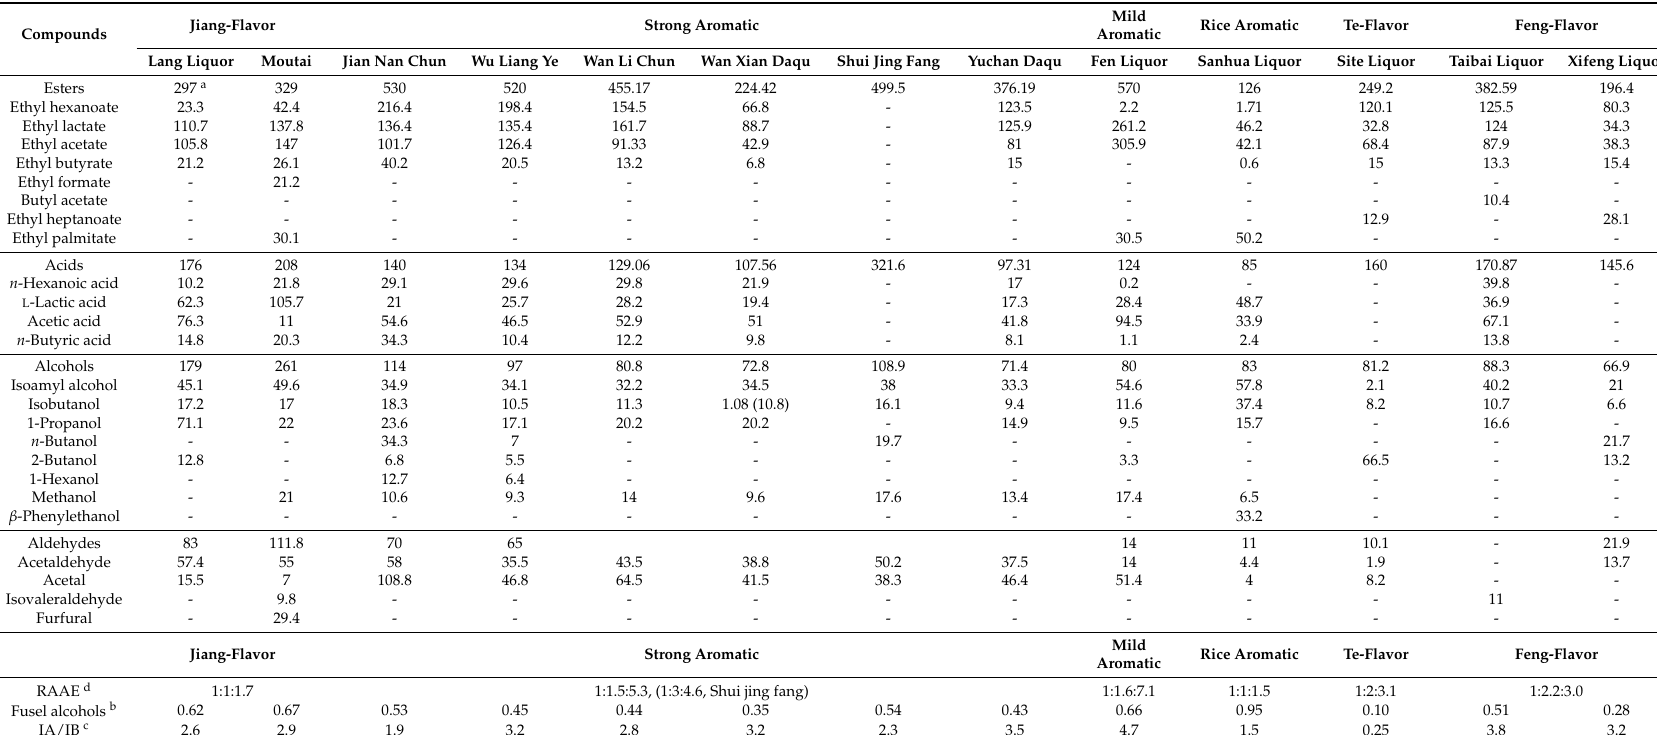
Table 1. Characteristic compounds in 13 commercial Chinese